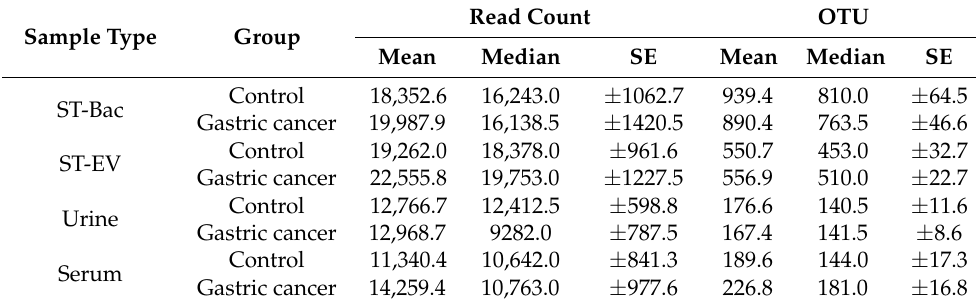
Table 2. Read numbers of 16S rRNA amplicons and OTU counts from the NGS results.